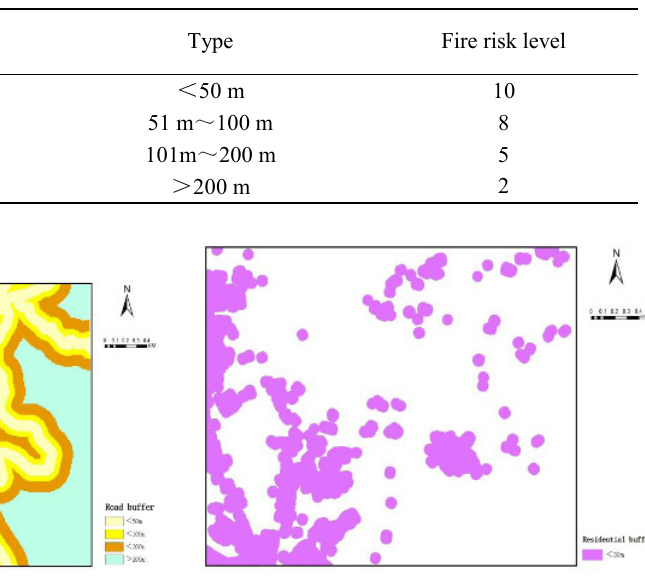
Fig. 7. Road buffer factor level. Fig. 8. Resident buffer factor